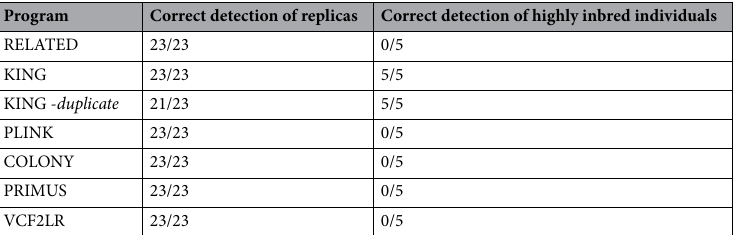
Table 1. Results of the individual identification performed with different programs. Correct detection of replicas corresponds to the detection of the 23 pairs of duplicated samples. Correct detection of highly inbred individuals corresponds to the detection of the 4 available sequencing experiments of the 3 individuals from Amundarain-Zaldibia.